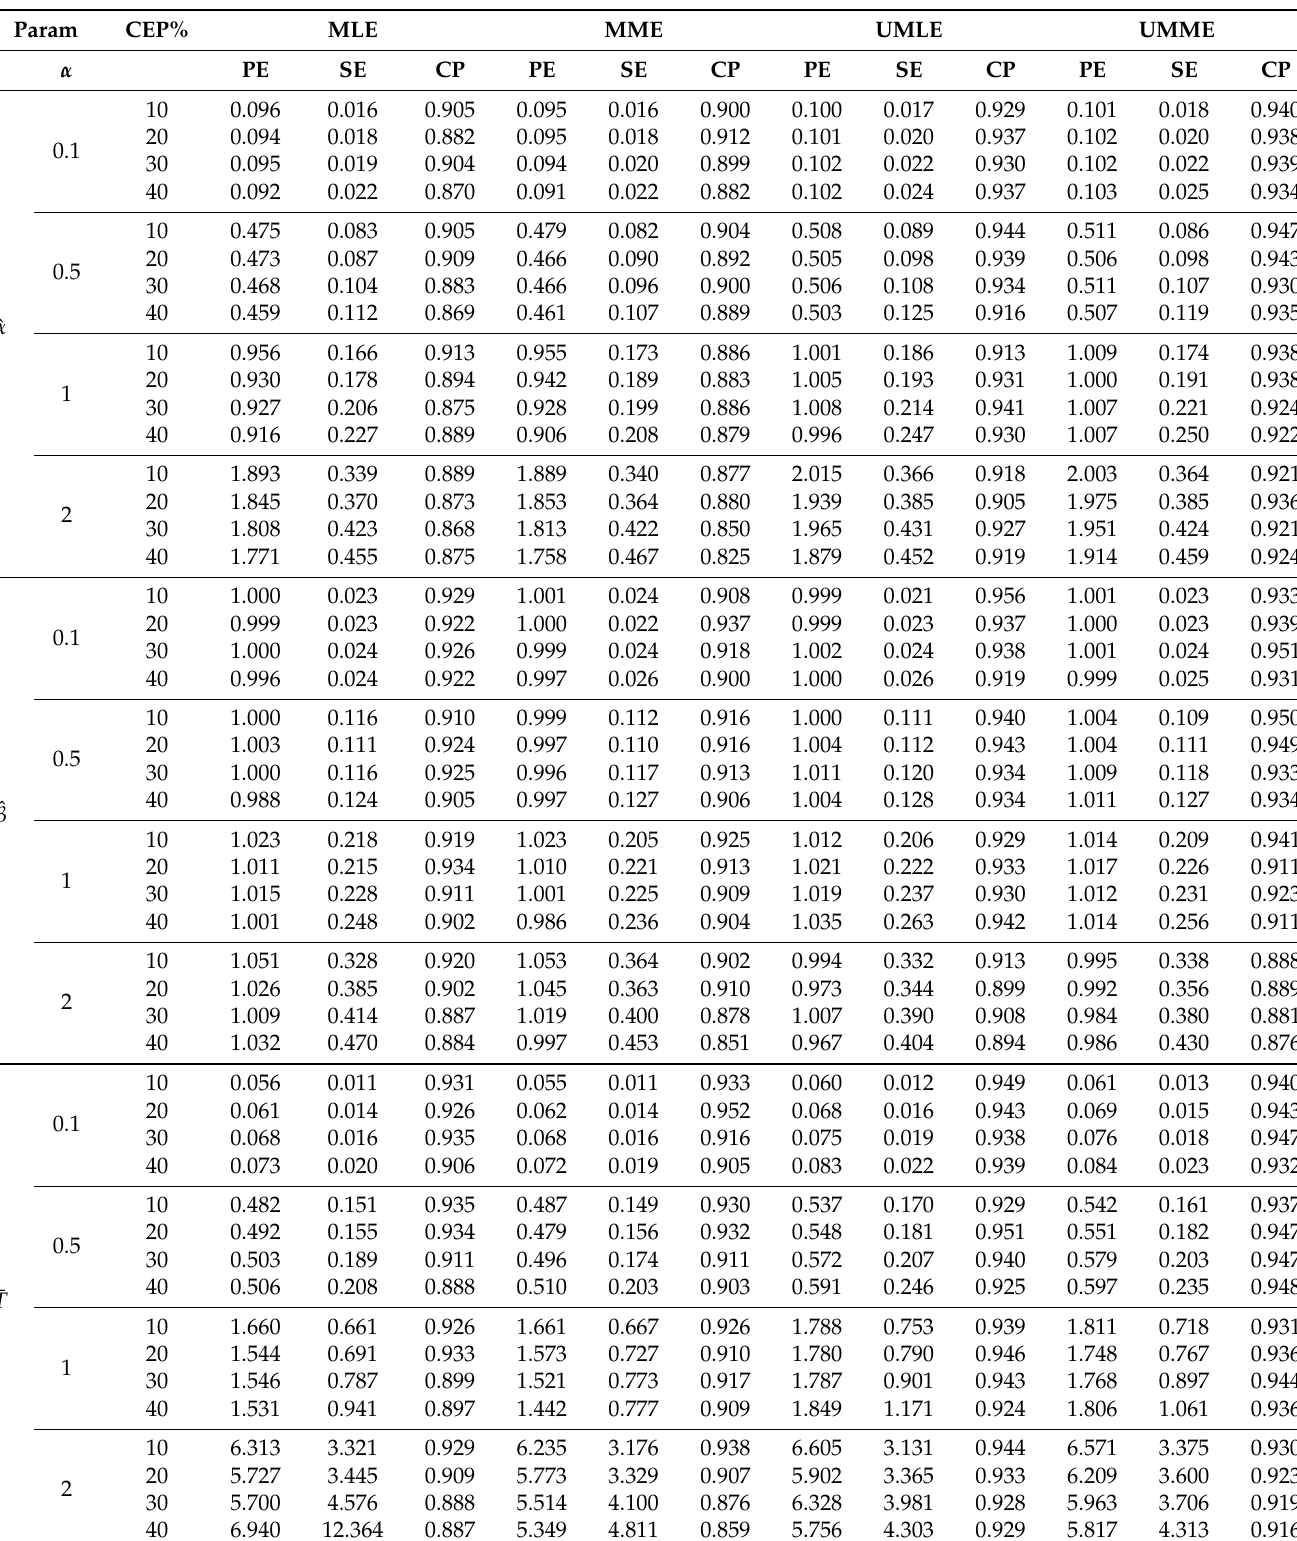
Table A2. Mean and standard error of the point estimates and probability coverages of 95% confidence intervals based on Monte-Carlo simulation ( n =